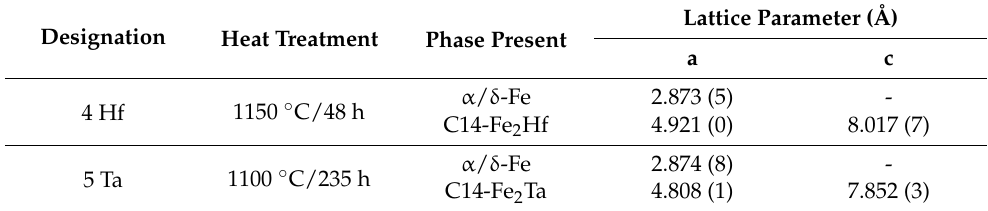
Table 2. The estimated lattice parameters of the phases present in the alloys after heat treatments.